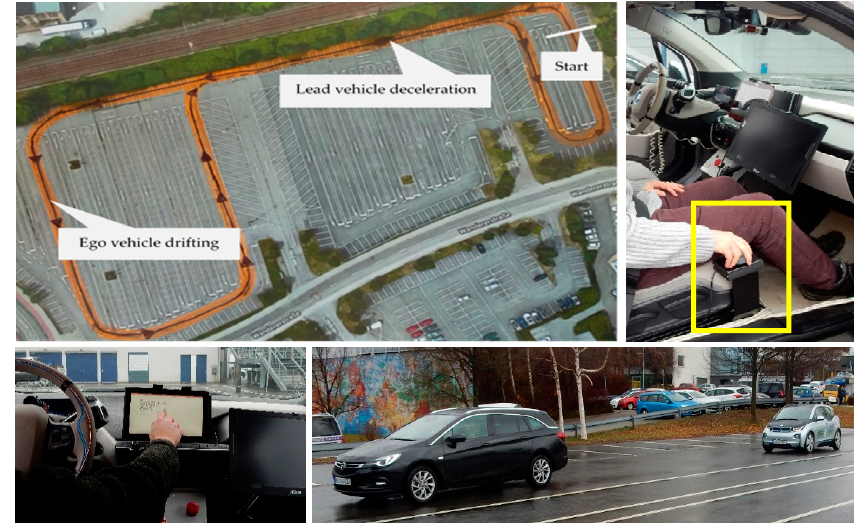
Figure 1. Test track depicting the two take-over situation locations ( top row , left ), the execution of lateral vehicle control via Wizard-of-Oz ( top row , right ), experimental setup within the ego vehicle ( bottom row , left ), and the two vehicles involved in the driving scenario ( bottom row , right ). Table 1. Differences and similarities between the simulator and test track.